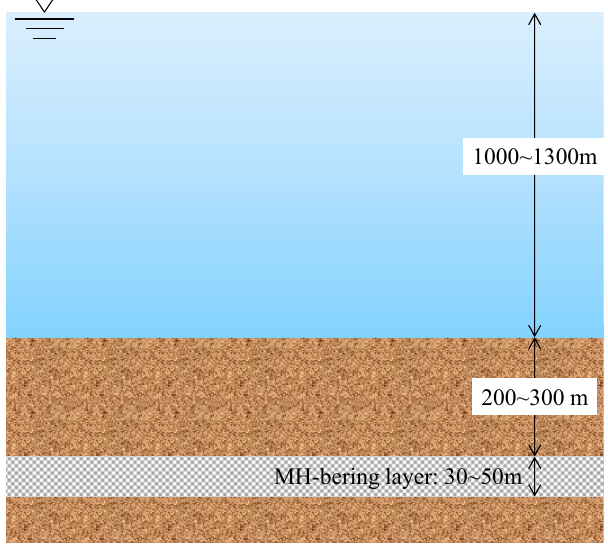
Figure 3. Schematic view of the target area of MH-bearing sediments for the numerical